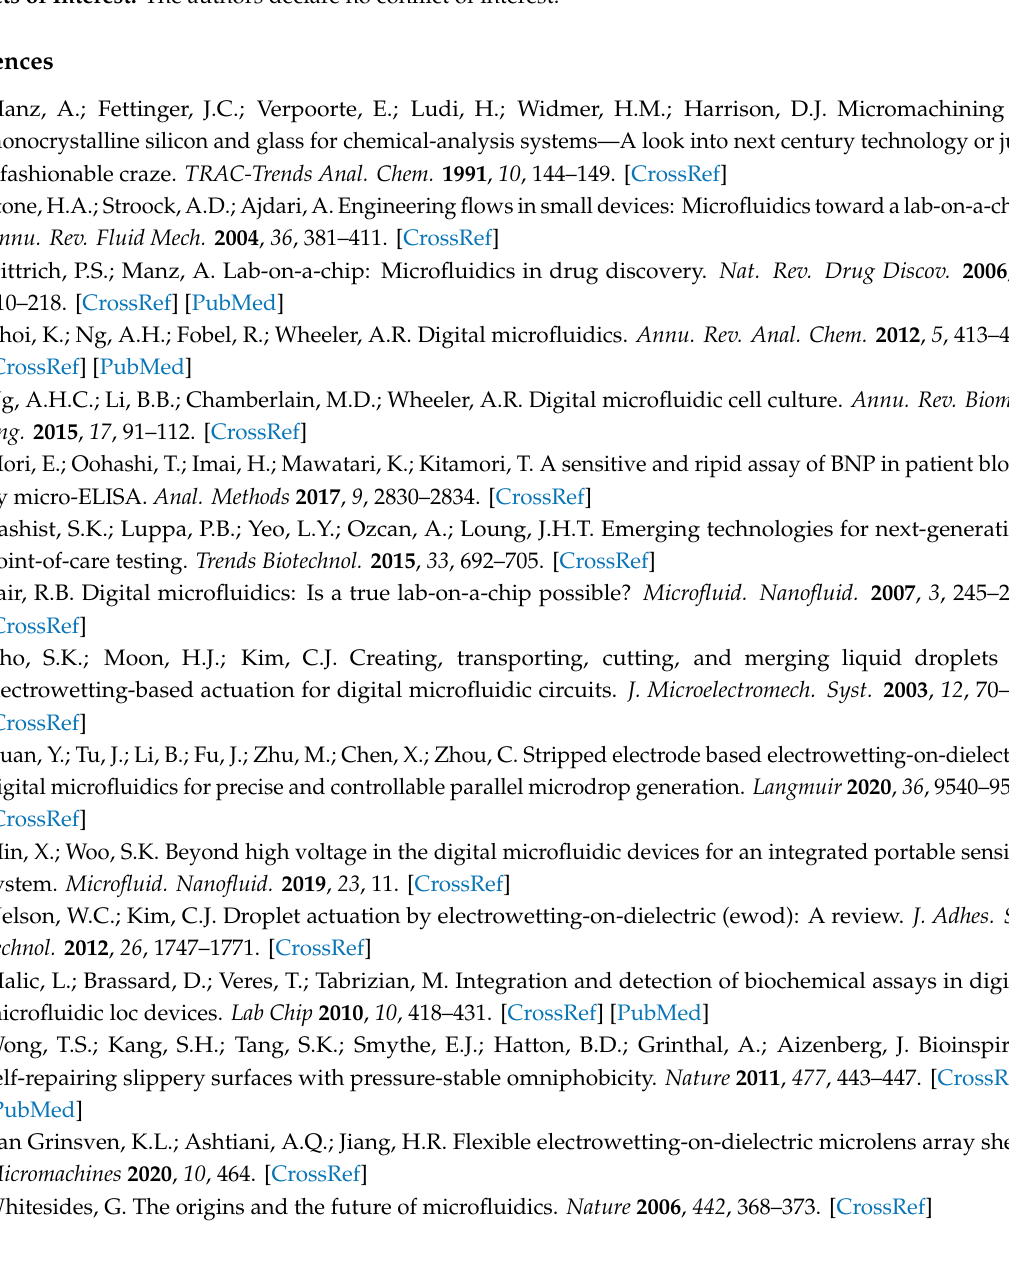
Figure S1: Comparison curves of physical representation values with di ff erent splicing situations. ( a ) The curve of the relationship between gap width and spacer numbers; ( b ) The curve of the relation between height di ff erence and spacer numbers; ( c ) The curve of the relationship between electrode misalignment and spacer numbers. Video S1: The video of the droplet actuation from ITO-glass chips to PCB